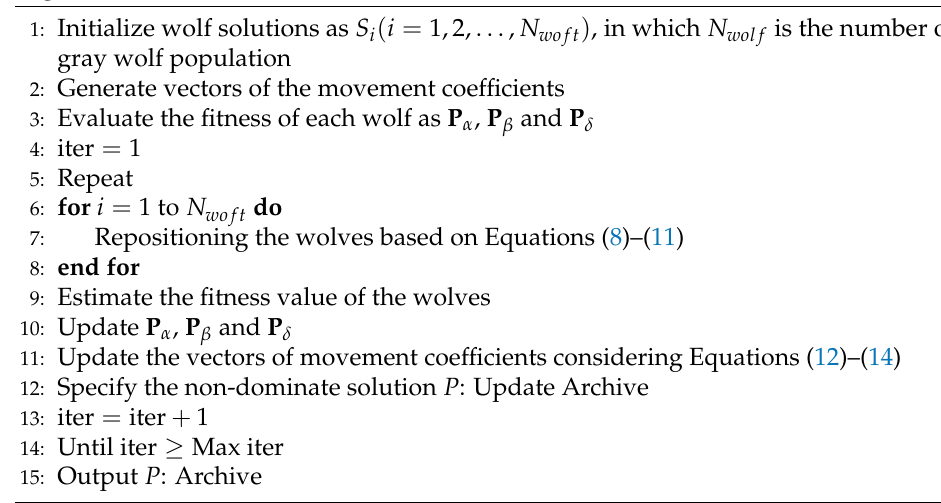
Algorithm 1 Pseudo-code of